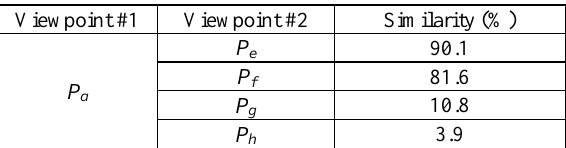
Figure 5. Coplnarity Condition